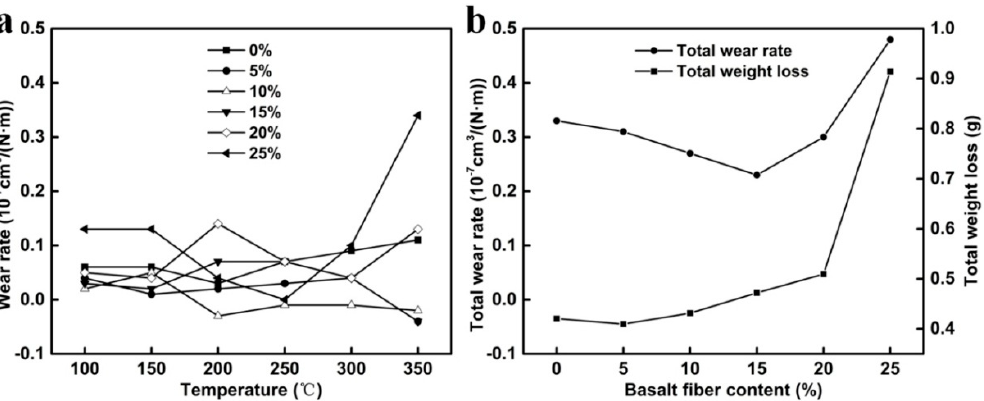
Figure 6. ( a ) Variations of wear rate of the friction composites with basalt fiber content and temperature; ( b ) Variations of total weight loss and total wear rate of the friction composites with basalt fiber content.